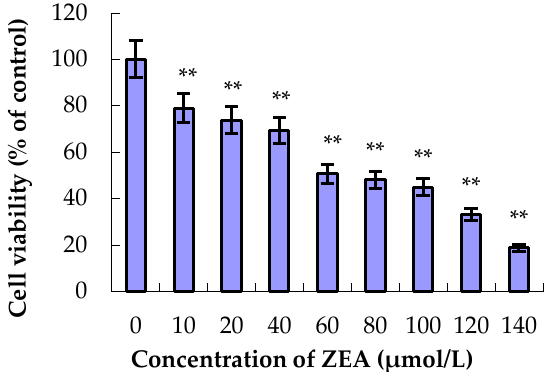
Figure 2. Effects of zearalenone (ZEA) on the viability of MODE-K cells. The relative survival rate of MODE-K cells gradually decreased with the increase in ZEA concentration when the cells were treated with ZEA for 24 h. The half-inhibitory concentration of ZEA on MODE-K cells was 65 µ mol/L. ** p < 0.01 vs. control group.